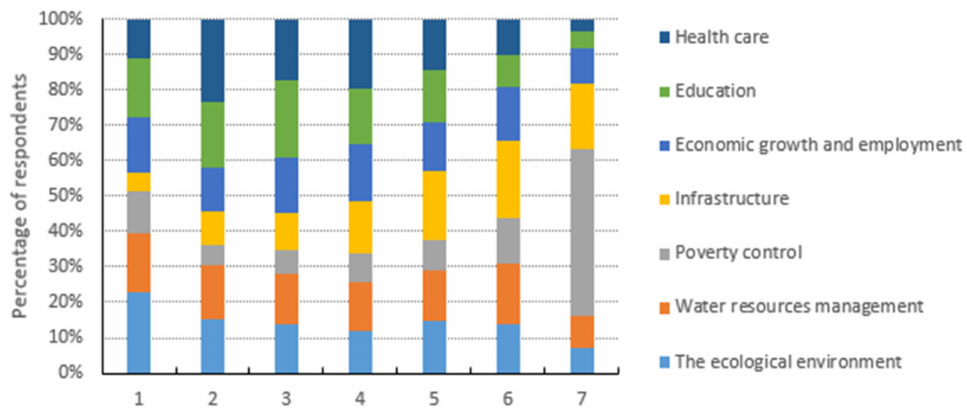
Figure 2. Rankings of importance for socio-economic and environmental issues.